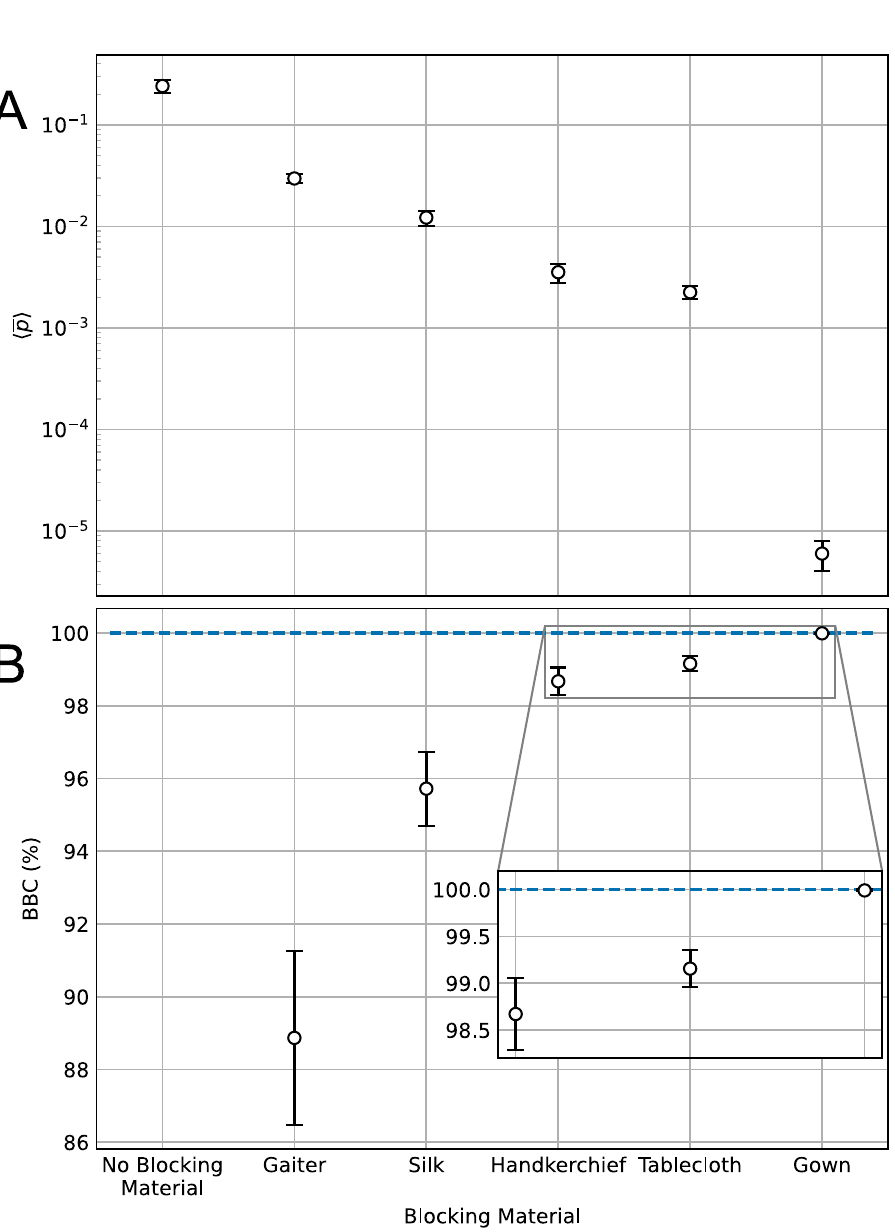
Fig 3. Ballistic blocking for various fabrics. (A) Values of h � p for different blocking materials in CONF1 (notice that both h � p same materials, calculated through Formula (1). Inset: zoom near BBC = 100%. See Sec. C in S1 File for uncertainty